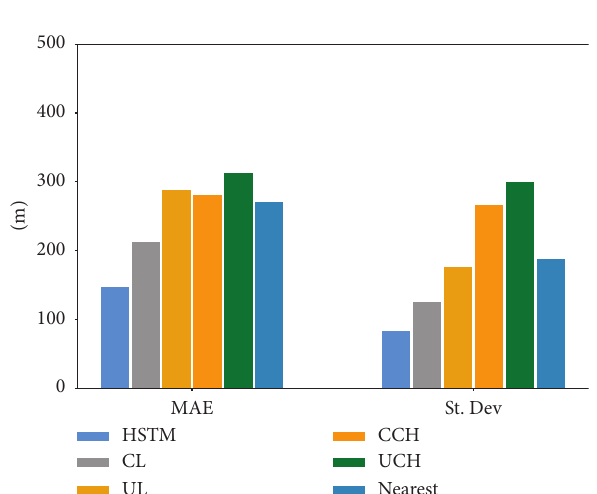
Figure 8: Comparison of five heuristic optimizations.